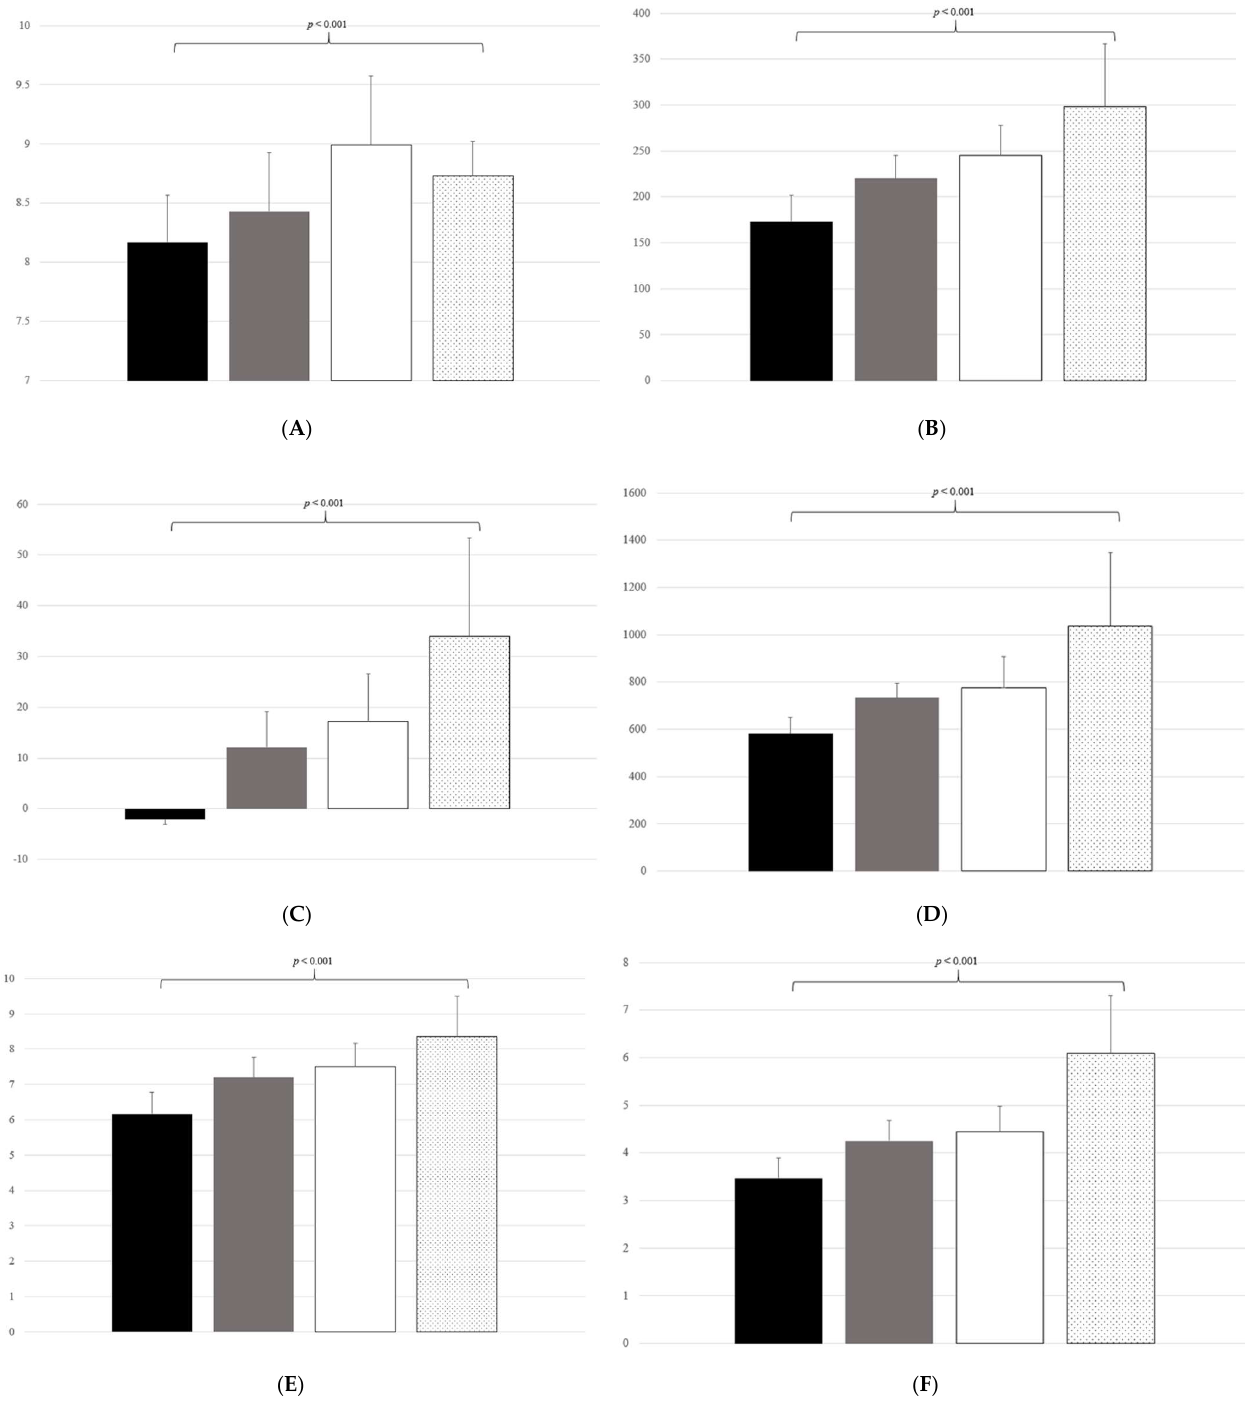
Figure 2. TyG and modified TyG indices according to the NAFLD grade. The black bar is the NAFLD grade group, the gray bar is the NAFLD grade 1 group, the white bar is the NAFLD grade 2 group, and the bar with the dotted pattern is the NAFLD grade 3 group. The number on the bar is the p -value of the analysis of variance. ( A ) TyG index according to the NAFLD grade. ( B ) TyG-BMI according to the NAFLD grade. ( C ) TyG-BMI SDS according to the NAFLD grade. ( D ) TyG-WC according to the NAFLD grade. ( E ) TyG-WHR according to the NAFLD grade. ( F ) TyG-WHtR according to the NAFLD grade. TyG, triglyceride glucose index; NAFLD, non-alcoholic fatty liver disease; BMI, body mass index; SDS, standard deviation score; WC, waist circumference; WHR, waist-to-hip ratio; WHtR, waist-to-height ratio.